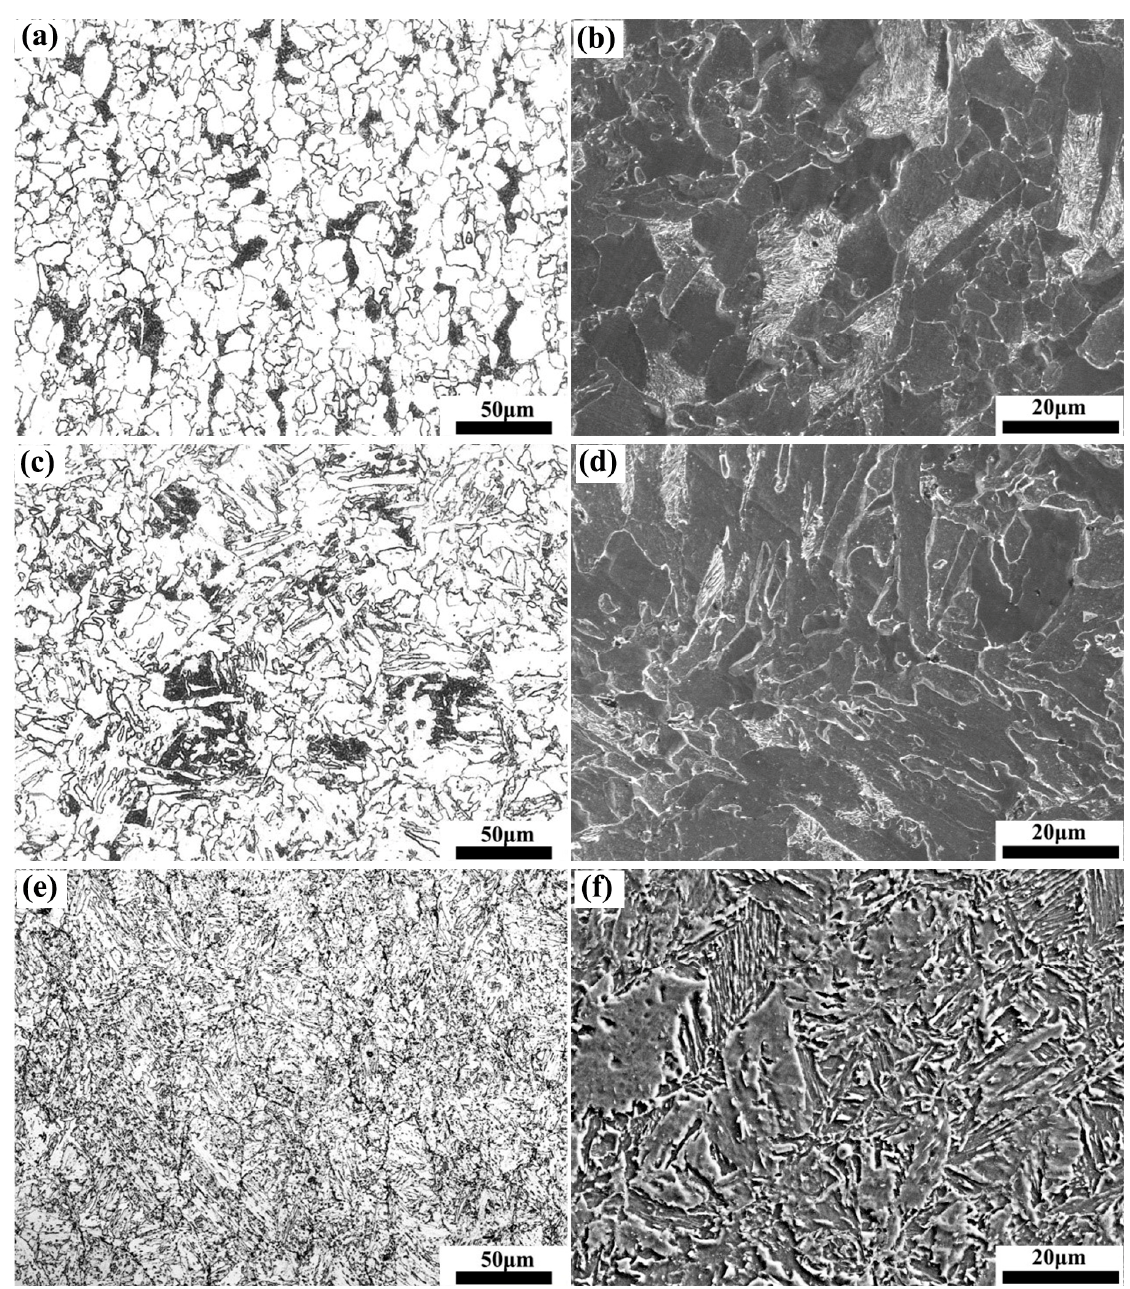
Figure 5. Microstructure of test steel at di ff erent coiling temperatures: ( a , b ) 650 °C; ( c , d ) 600 °C; ( e , f ) 550 °C.